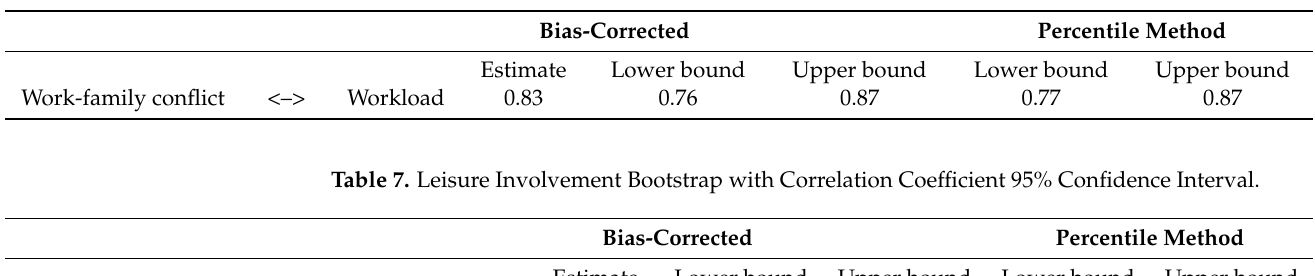
Table 6. Job Demands Bootstrap with Correlation Coefficient 95% Confidence Interval.